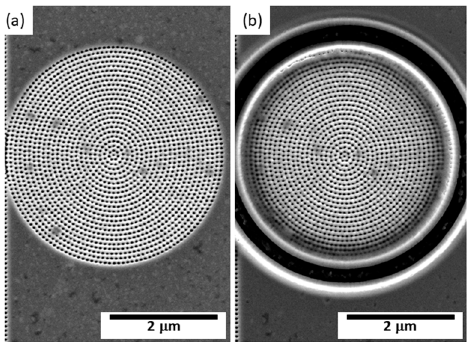
Figure 5. ( a ) Visualization of an FIB-produced speckle on a Cr(III) coating ( a ) before ablation and ( b ) after ablation of the ring groove.